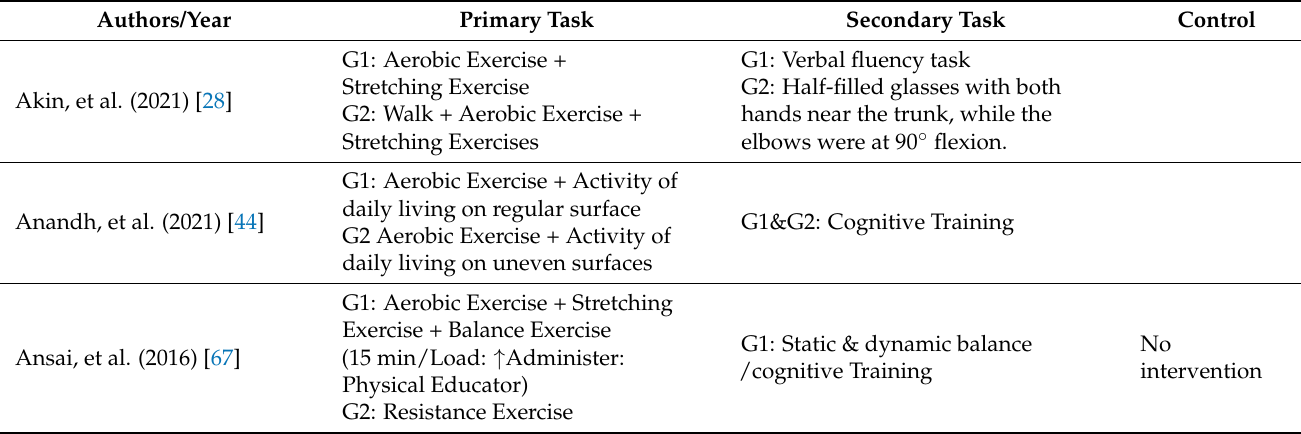
Table A3. Details of the DT training and